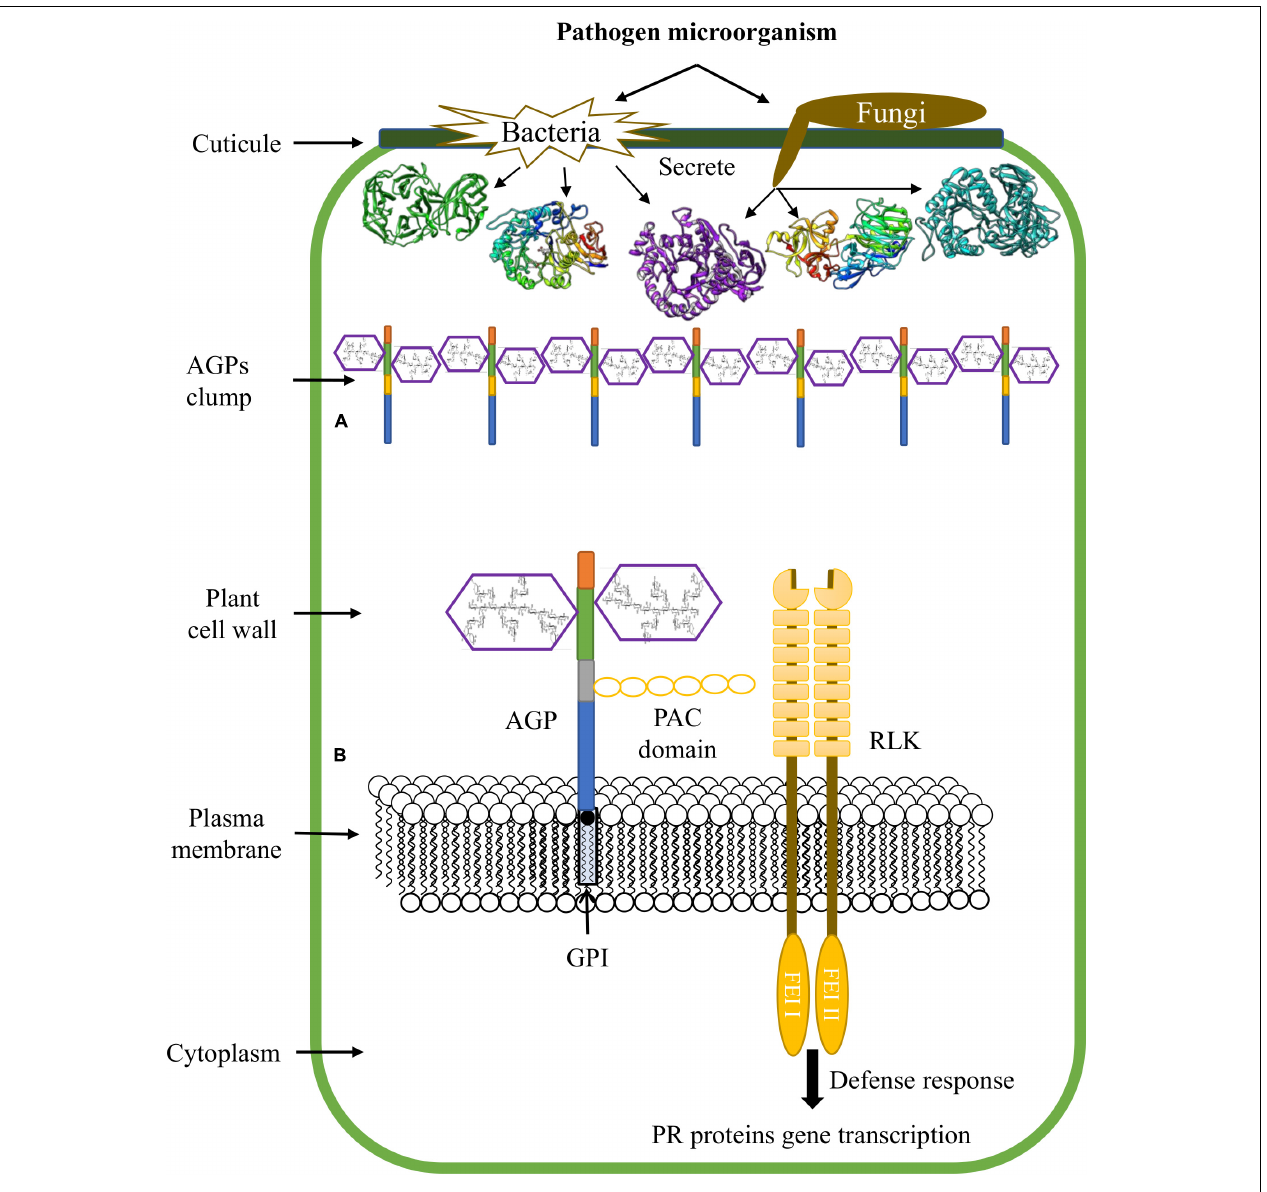
FIGURE 3 | Functions of AGPs during plant-microbe interactions. (A) Accumulation of AGPs at sites of pathogen infection. (B) AGPs are involved in transduction pathways and promote plant defense